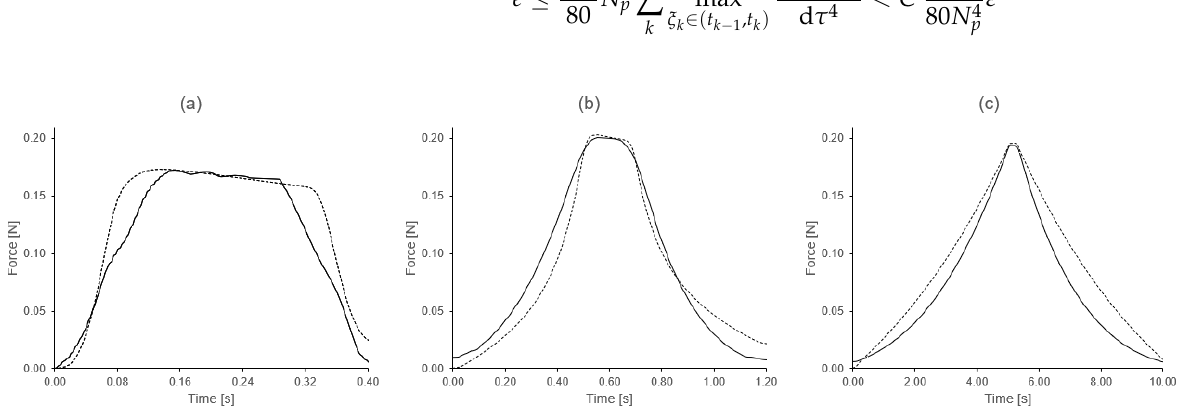
Figure 7. Experimental force–time curves compared with model predictions: ( a ) fast curve (˙ ε ≈ 1 s − 1 ), ( b ) medium velocity curve (˙ ε ≈ 0.1 s − 1 ) and ( c ) slow curve (˙ ε ≈ 0.01 s − 1 ). The predicted curve has been obtained by numerical integration. The cumulative integration error is larger for the slow curve and smaller for the fast curve. However, the fast curve seems to have a larger measurement error. Possibly, for that reason, the best fit is obtained for the medium speed